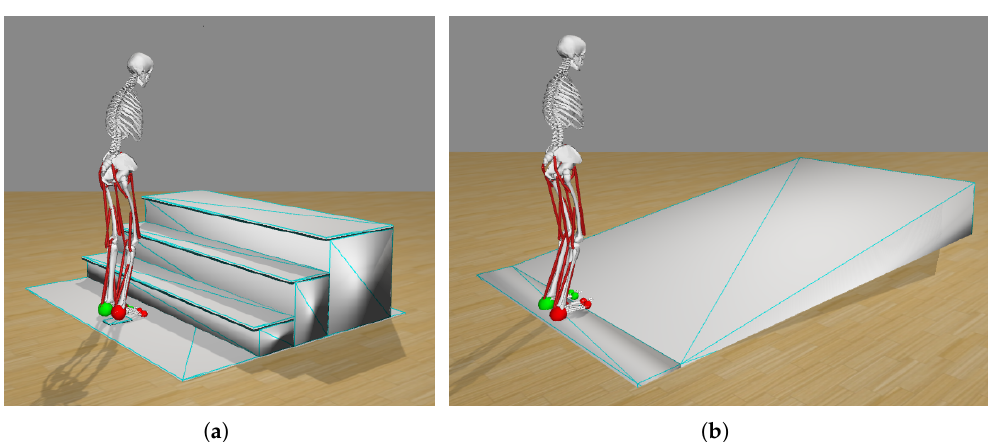
Figure 4. Simulation environments: Objects and human model at the starting position of the experi- mental dataset. ( a ) Stairs (with three steps). ( b )